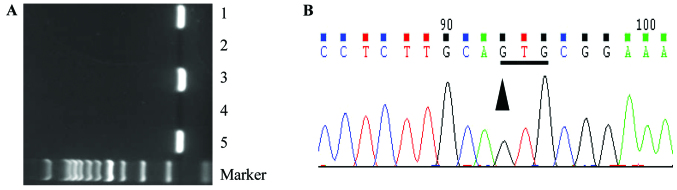
(A) Agarose gel image illustrating the genotyping of the transgenic mouse model. The size of the PCR product was 168 bp. The arrow indicates the 200 bp size of the molecular marker. Lanes 1,3,5 represent the genomic DNA products of 3 positive transgenic mice after genotyping and PCR amplification. Lane 2 represents the corresponding region in the wild-type littermate that had no amplified PCR fragment. Lane 4 represents the negative result of water. This animal was used as a negative control in this experiment. (B) Direct DNA sequencing to confirm the presence of mutation. The arrow indicates the corresponding methionine to valine amino acid substitution of GATA4 M310V point mutation.